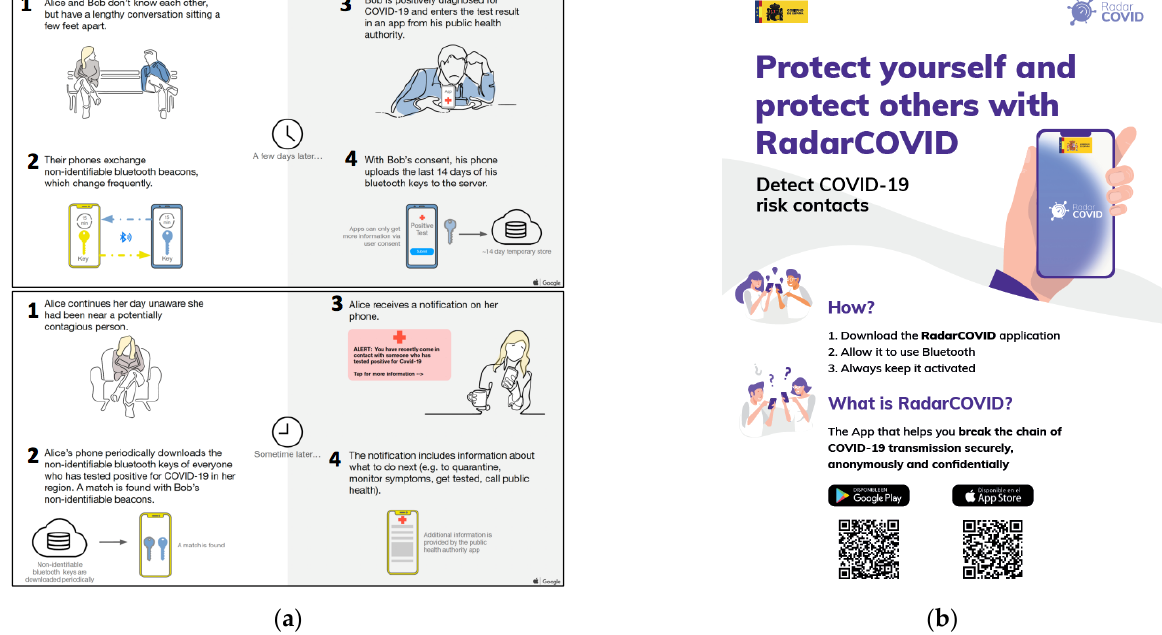
Figure 1. ( a ) Apple and Google COVID-19 exposure notification system framework (credit: Google/Apple Exposure Notification FAQ, p. 4, https://www.google.com/covid19/exposurenotifications/ (accessed on 26 April 2022)); ( b ) Radar Covid public campaign (Spain’s official Covid contact-tracing app) (Credit: [19]).